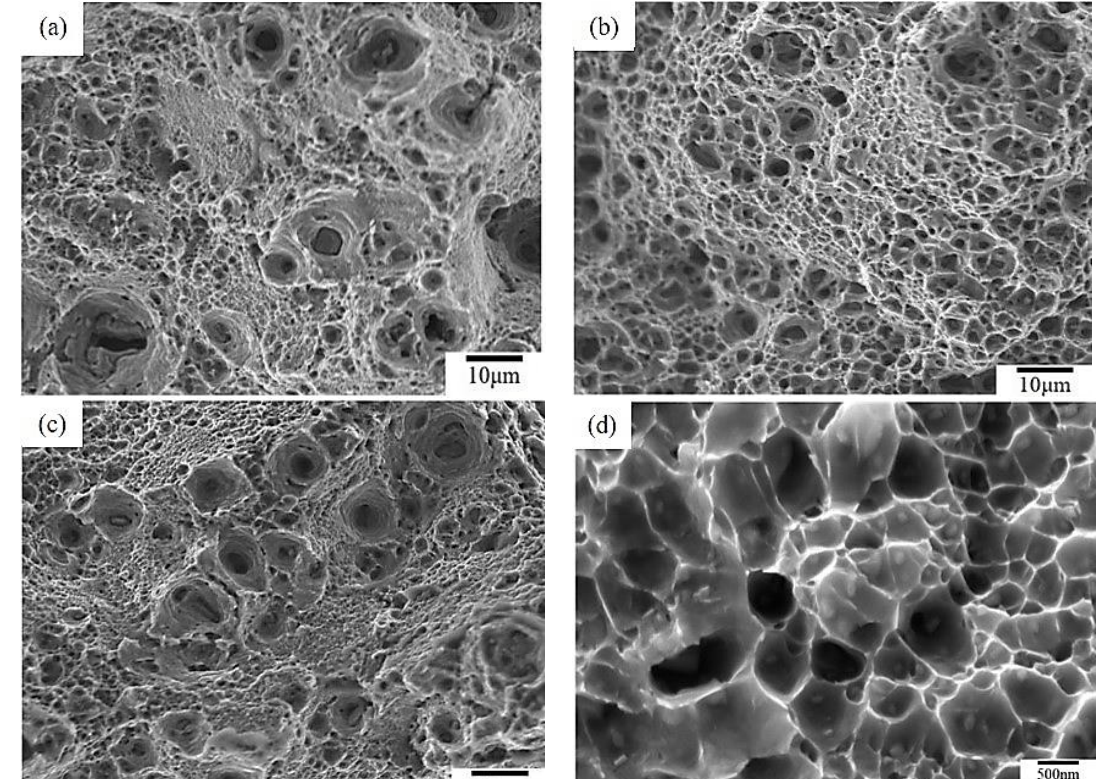
Figure 12. Fracture surfaces of 7075 Al alloy extruded rod with various PPHTs: ( a ) HTA240-8; ( b ) HTA280-12; ( c ) O; ( d ) HTA280-12 (high magnification).